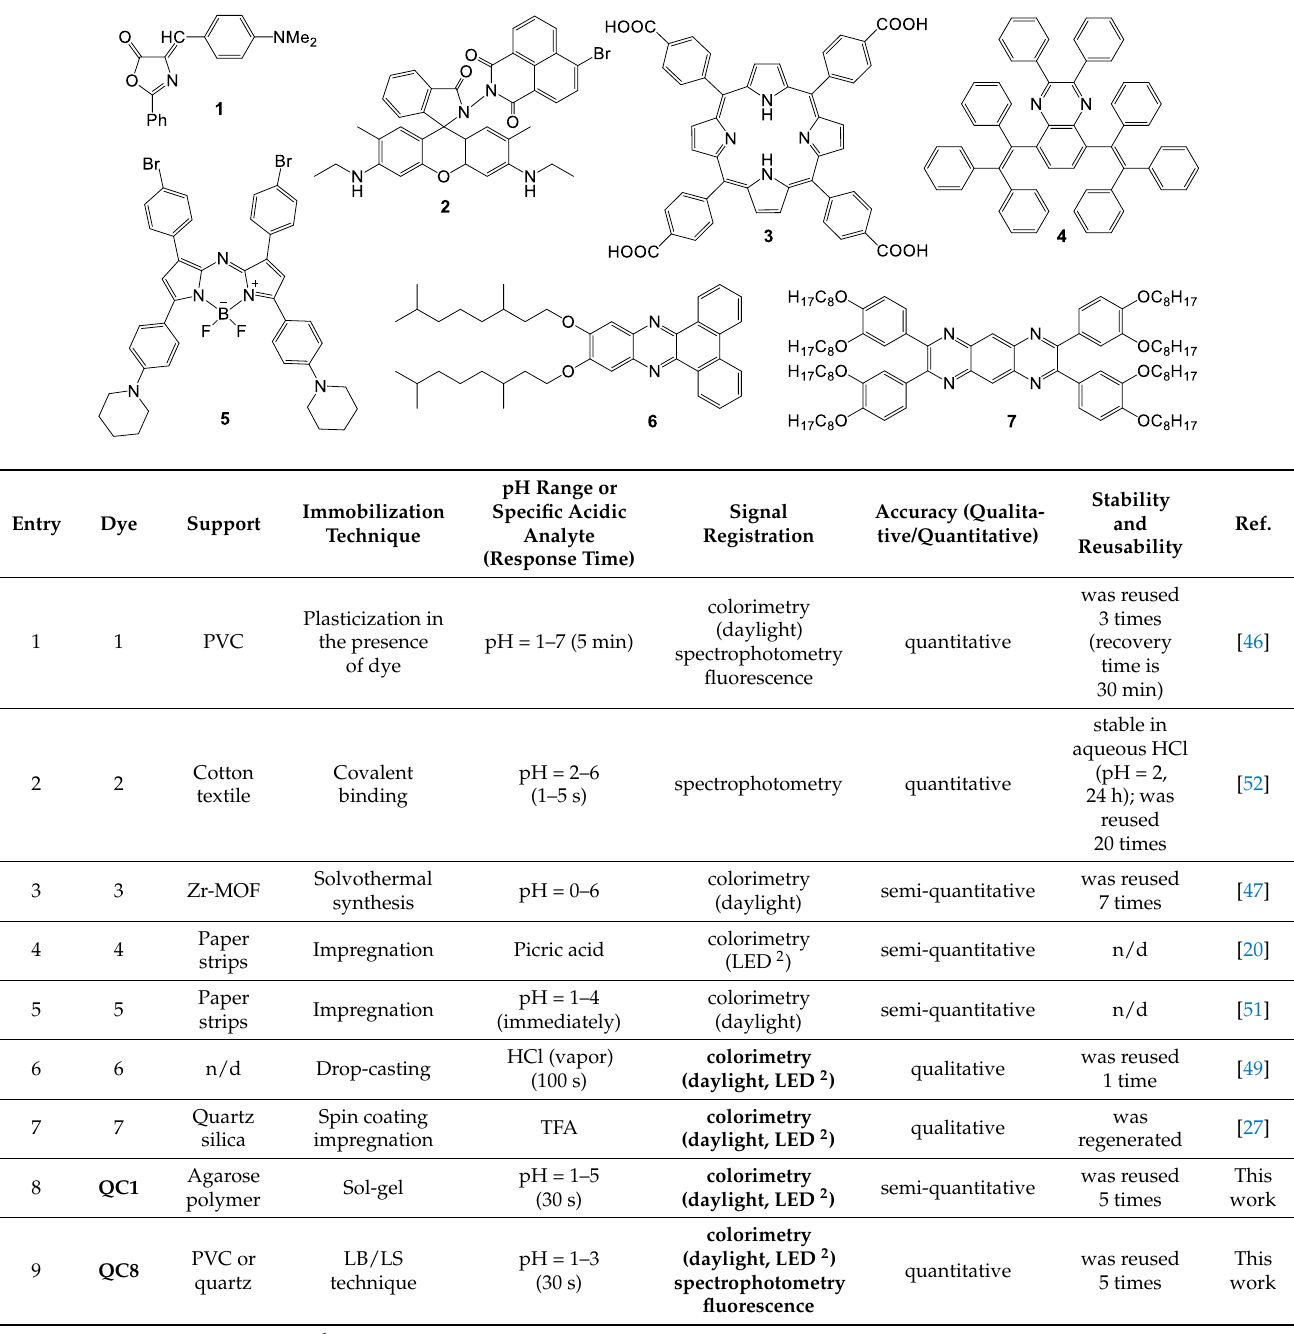
1 Abbreviations used in the table: MOF—metal–organic framework, Zr-MOF—MOF based on Zr clusters; LB/LS technique—Langmuir–Blodgett/Langmuir–Schäfer technique, PVC—polyvinylchloride, and n/d—not determined; dual-responsive materials are marked in bold. 2 illumination at 365